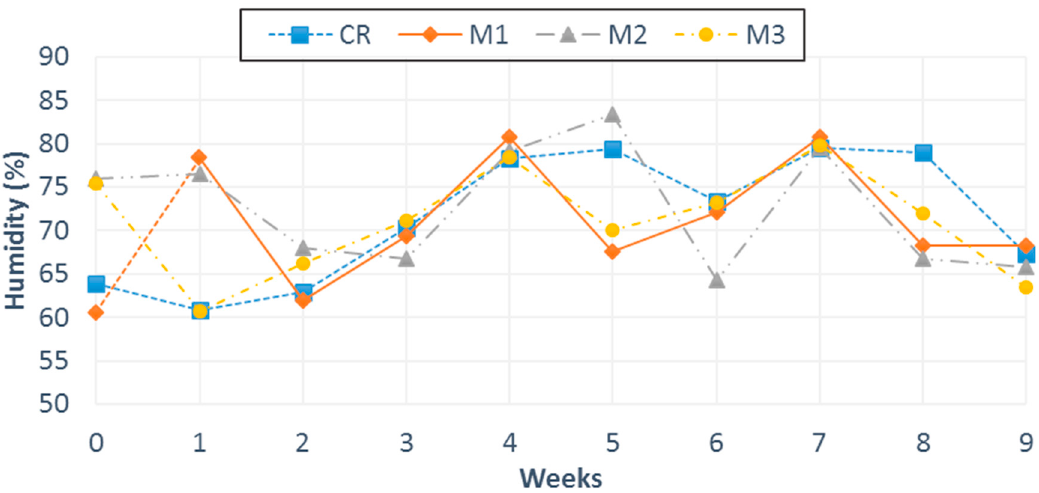
Figure 7. Behavior of humidity in the mixes during the vermicomposting process.